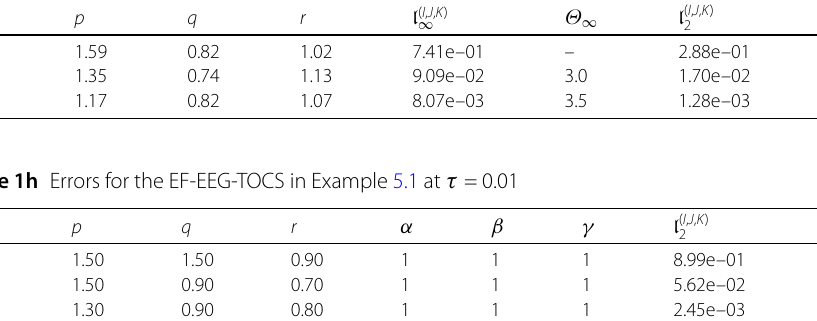
Table 1g Errors and order for EEG-TOCS in Example 5.1 at τ = 0.01 L + 1 p